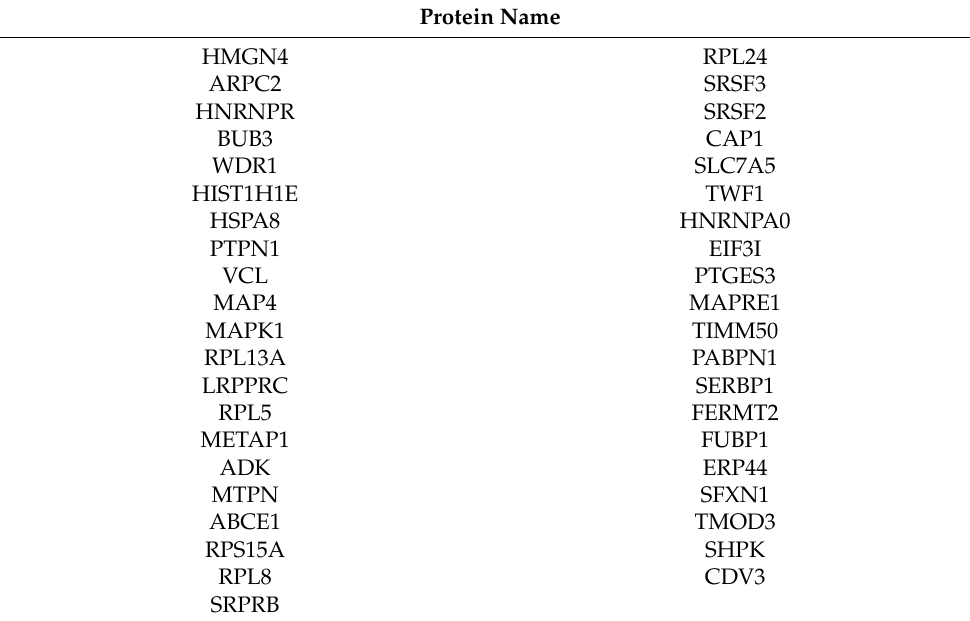
Table 2. Candidate target proteins of miR-130 family.